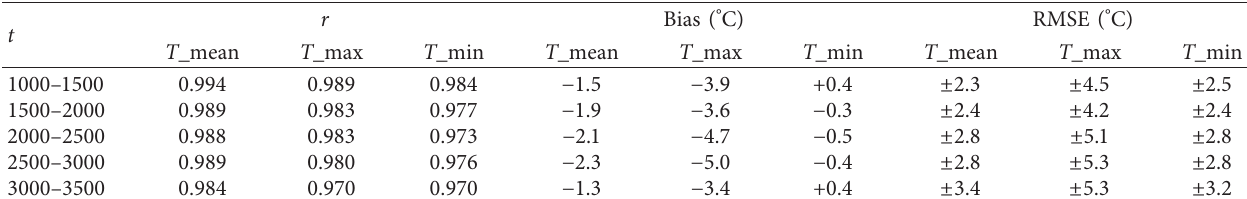
Figure 5: Relationship of bias and elevation differences between observations and ERA-Interim reanalysis in seasonal scales. (a) Spring. (b) Summer. (c) Autumn. (d) Winter. Table 5: Daily averaged ( r ), bias, and RMSE for different elevation groups.